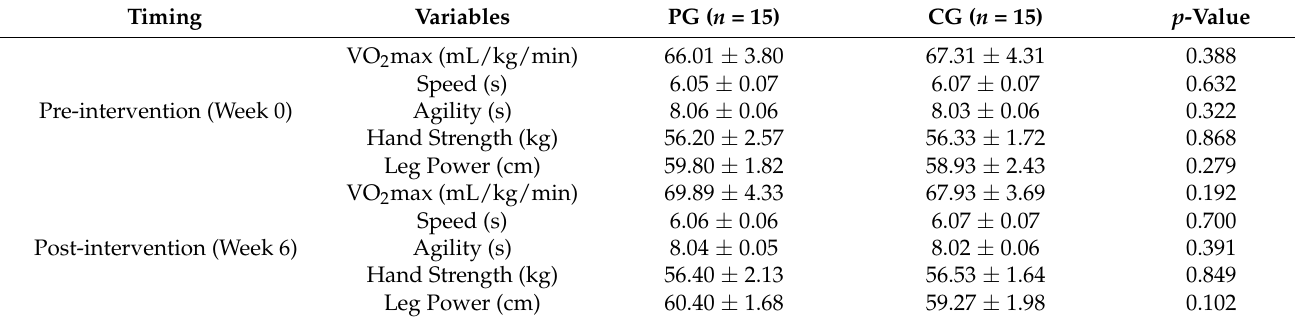
Table 7. Comparison of aerobic capacity (VO 2 max), speed, agility, hand strength and leg power between PG and CG at pre- and